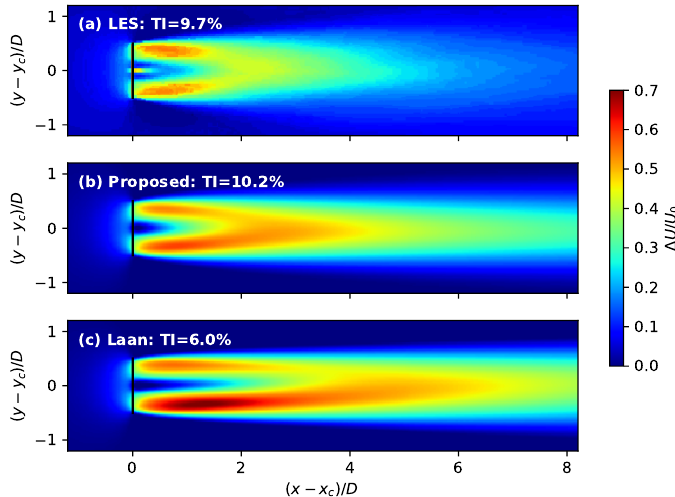
Figure 12. Normalized velocity distribution at hub height under the stable condition, where large eddy simulation (LES) data are modified from Machefaux et al. [1], where ( x c , y c , z c ) is the center point of the disk, ∆ U is the velocity deficit in the wake, and U 0 is the inlet